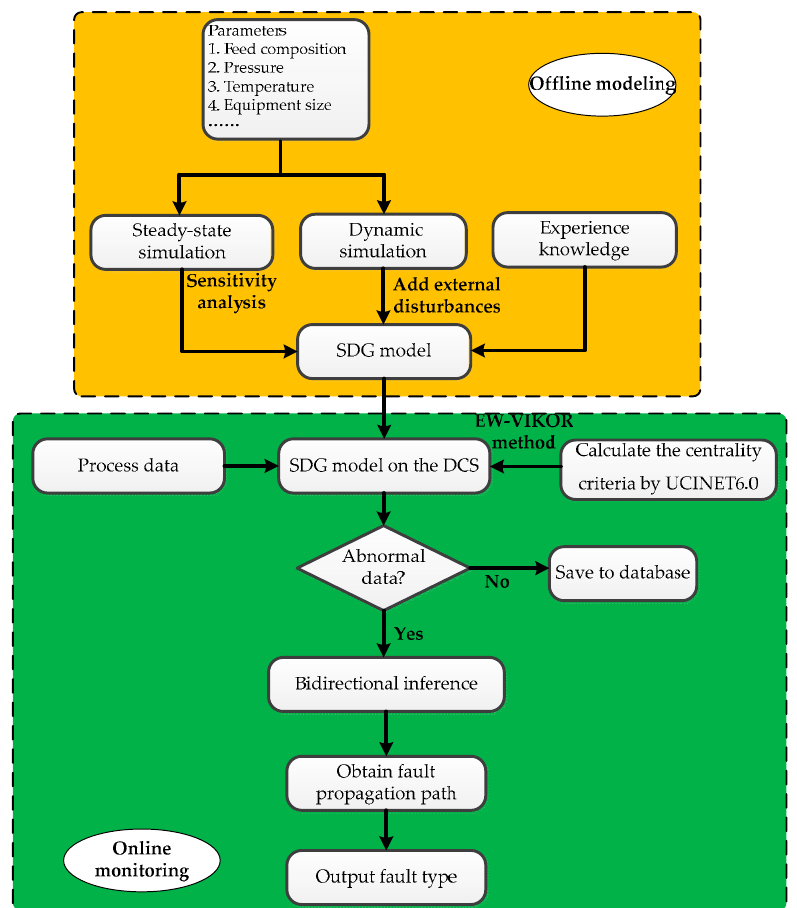
Figure 1. The framework of the dynamic mechanism analysis and signed directed graph (DMA- SDG) method.